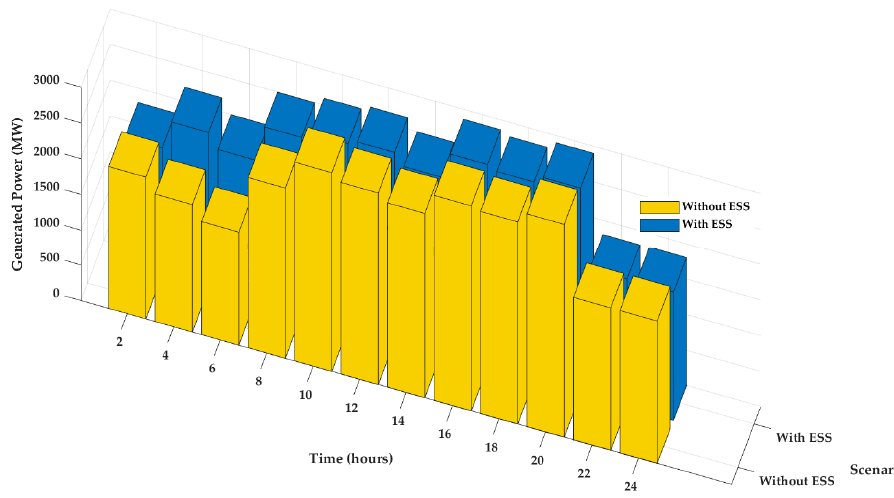
Figure 6. Load leveling features in the presence and absence of ESS. Table 1. Energy exchange between an SG, ESS, and load.